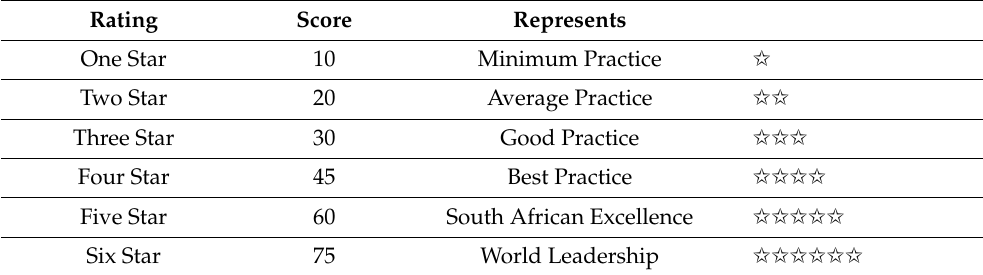
Table 1. Green Star SA rating as a quality factor